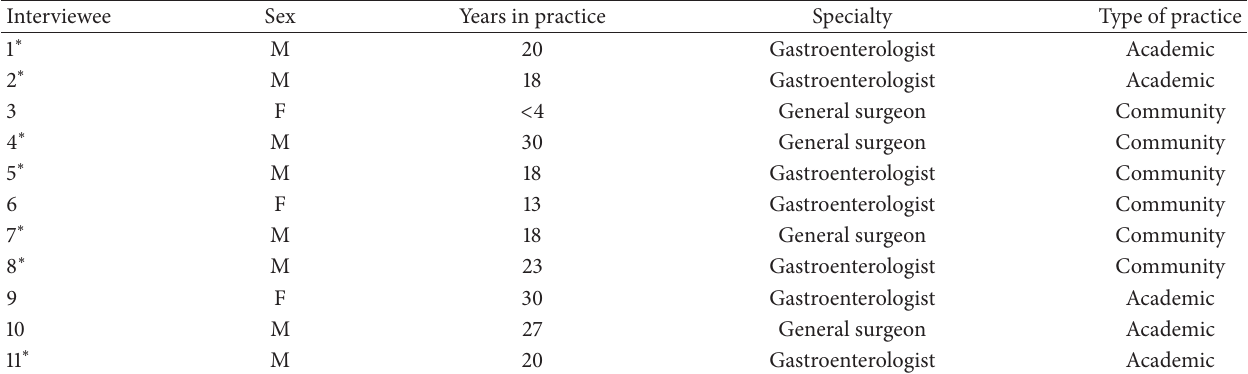
Table 1: Participant